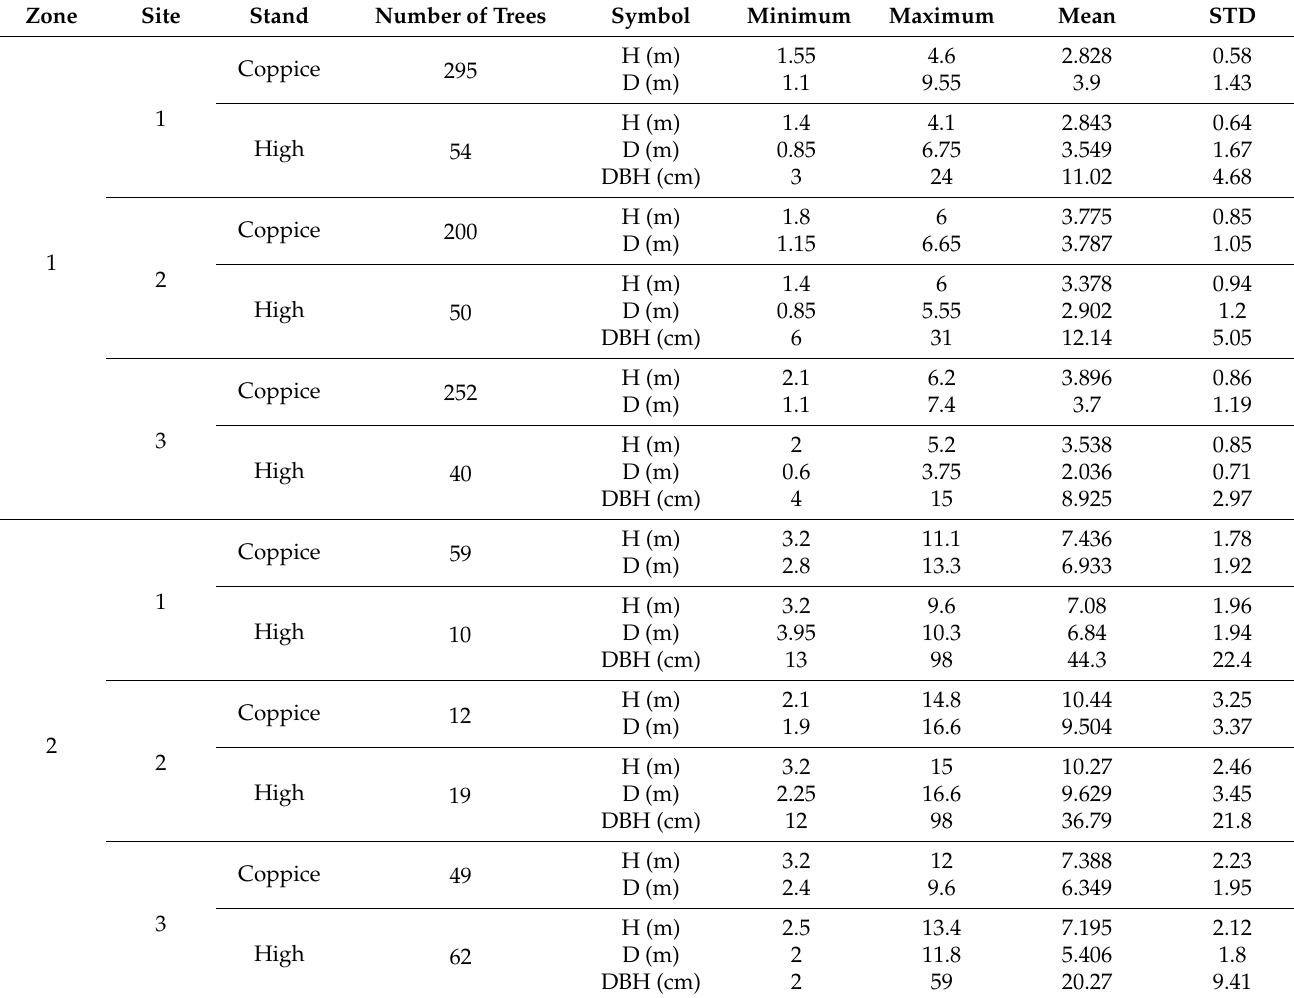
Table 2. Summary of ground measured